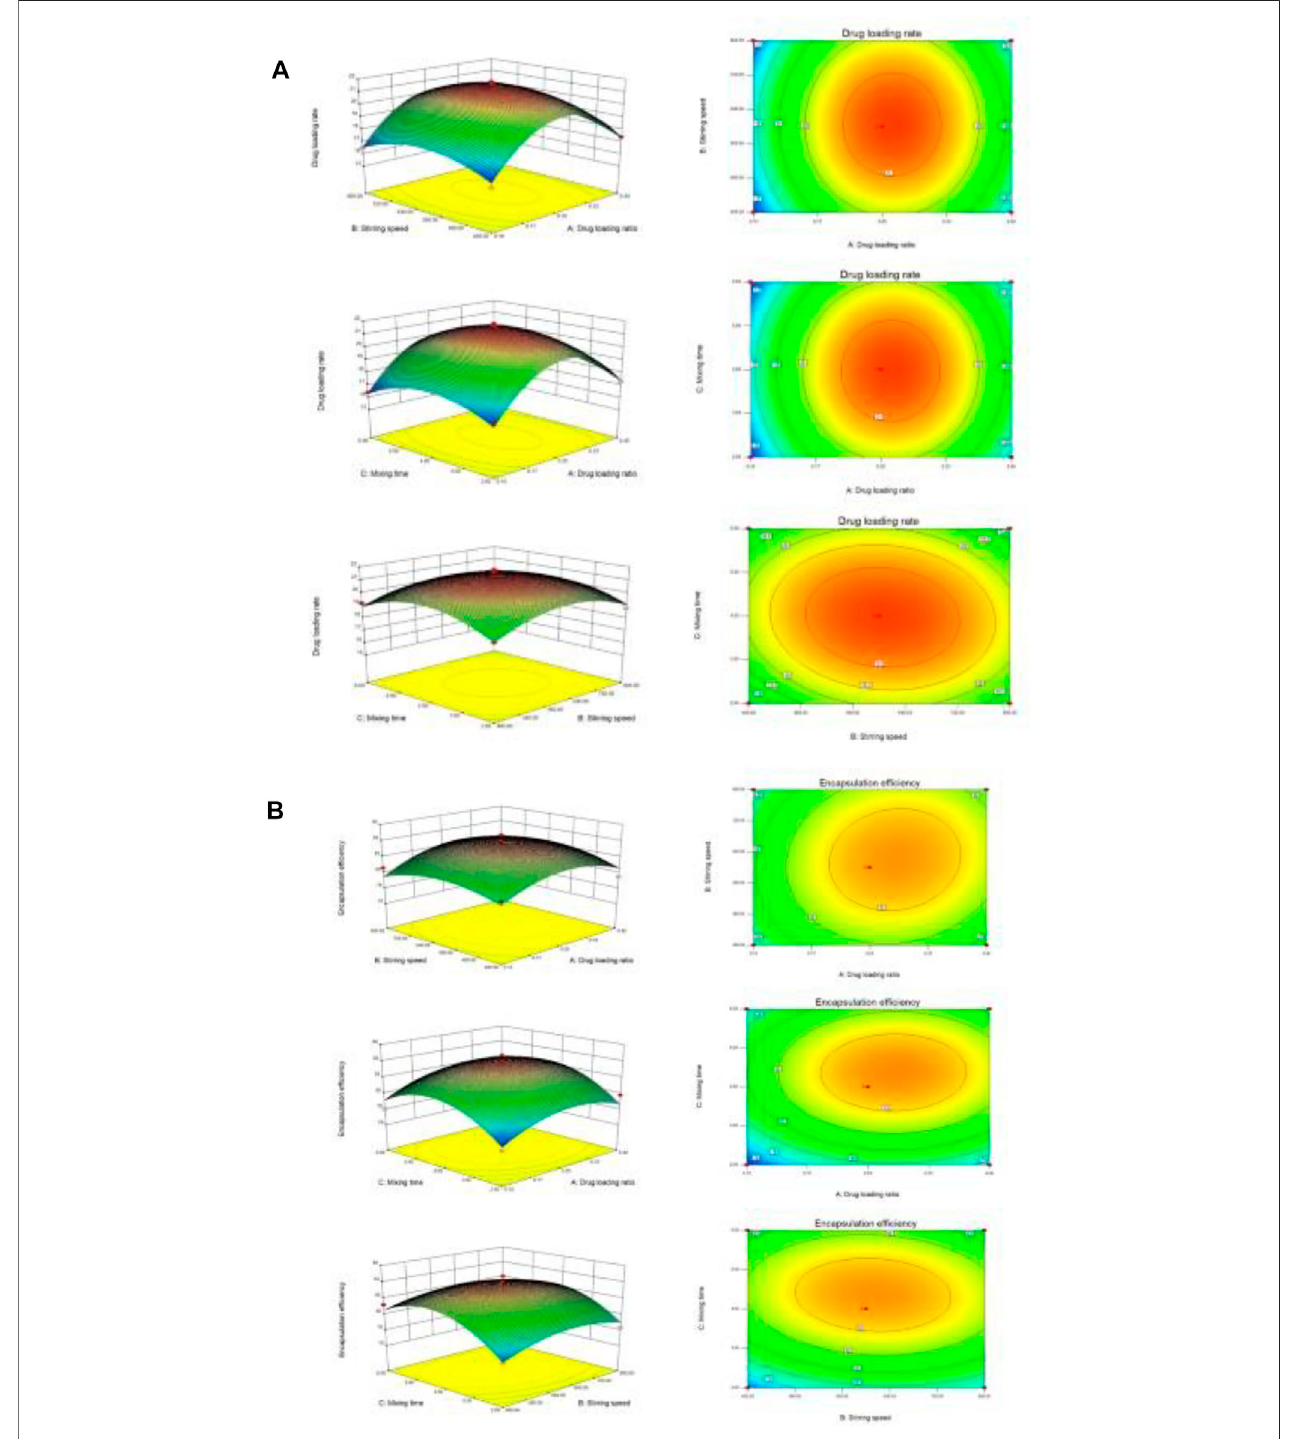
FIGURE 4 | 3-D response surface plots. (A) The in fl uence of independent variable factors on drug loading. (B) The in fl uence of independent variable factors on encapsulation ef fi ciency.